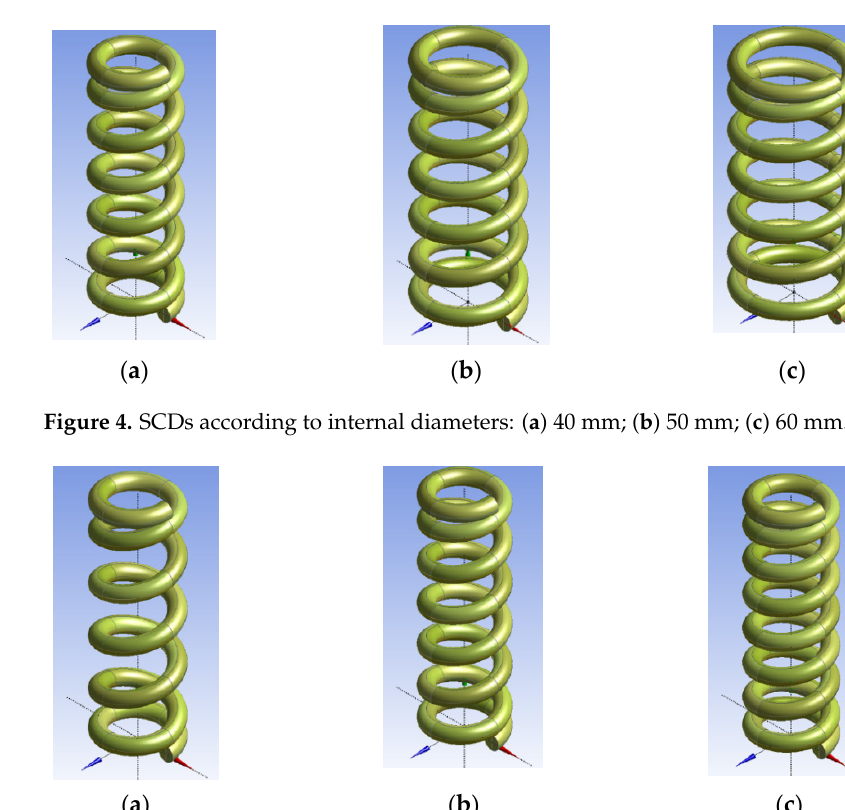
Figure 3. SCDs according to wire diameters: ( a ) 6 mm; ( b ) 8 mm; ( c ) 10 mm.